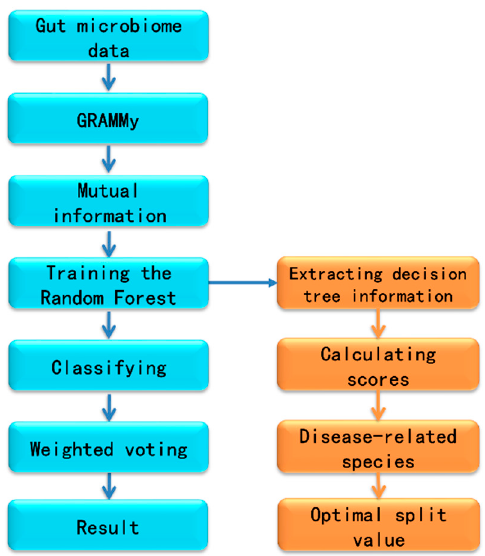
Figure 1. The workflow for metagenomic analysis.